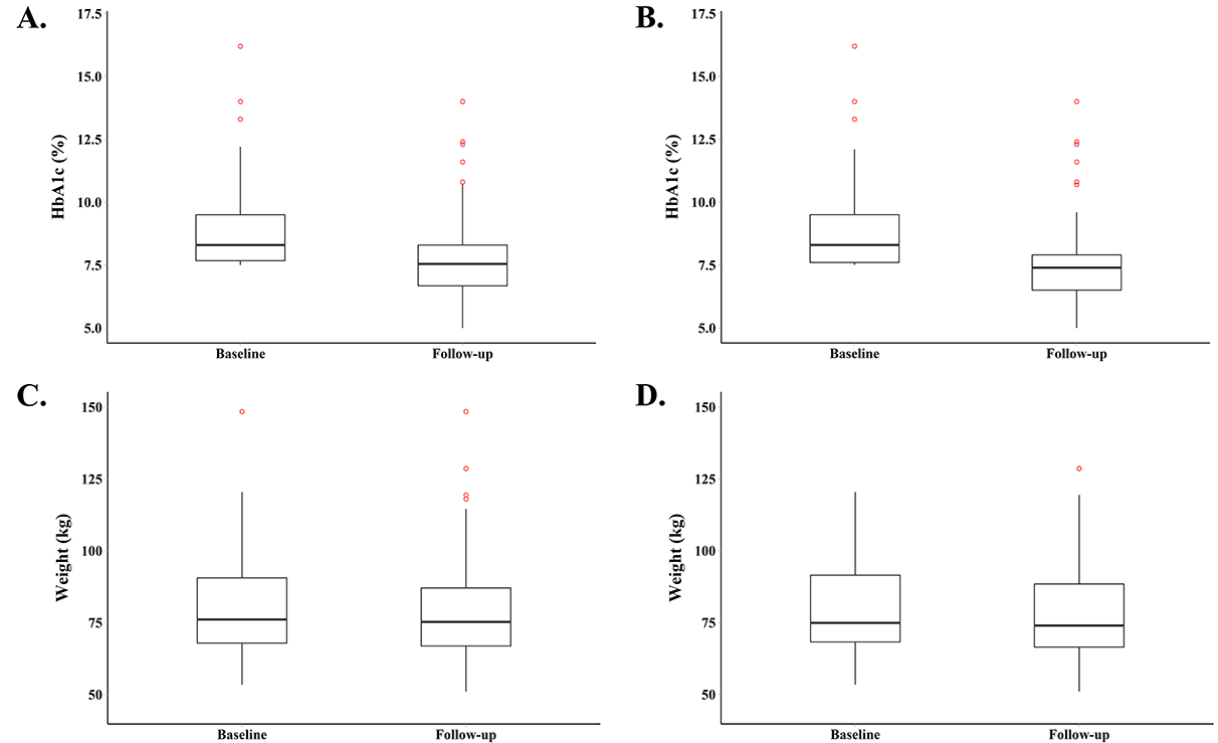
Figure 3. Distributions of health outcomes at baseline and follow-up: (A) HbA 1c for total sample (n=100), (B) HbA 1c for completes (n=83), (C) weight for total sample (n=100), and (D) weight for completes (n=83).